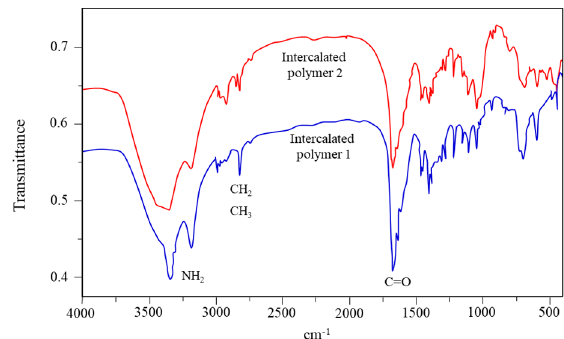
Figure 9. Infrared spectra of the intercalated polymers.